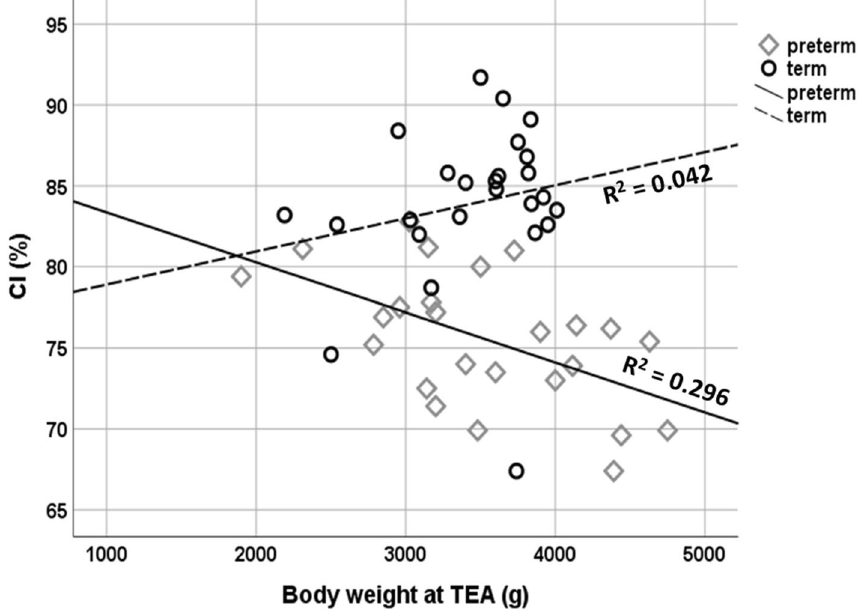
Figure 4. Correlation of body weight at term equivalent age and cranial index. CI cranial index, TEA term equivalent